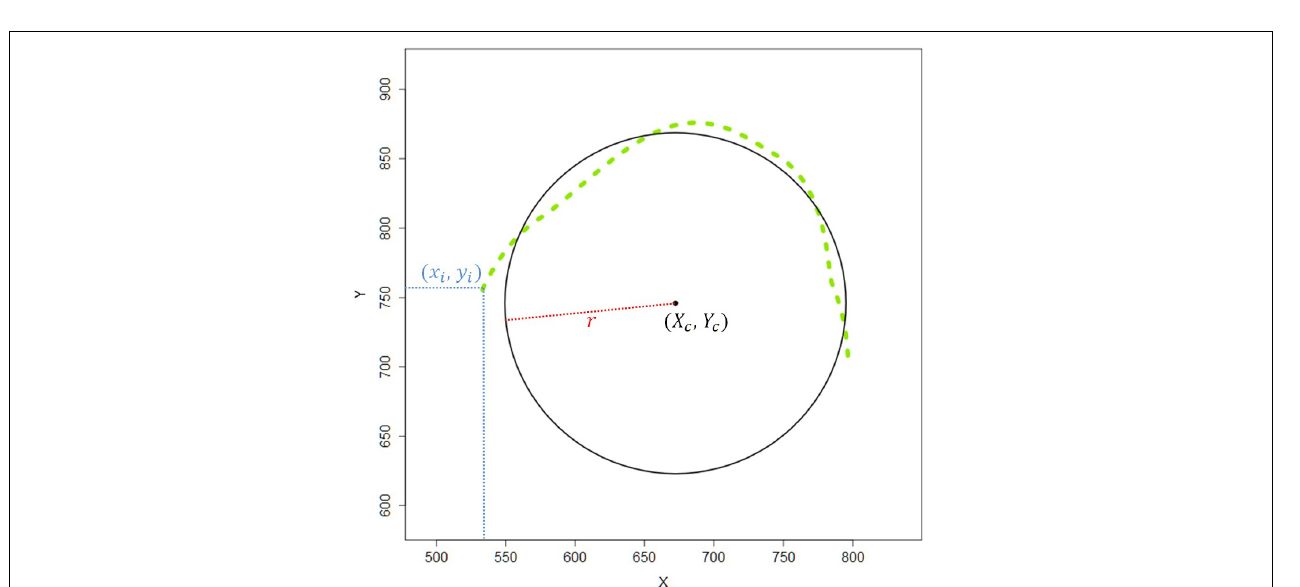
FIGURE A1 | Illustration for tongue center estimation as defined in Eq. 3. Dashed curvy green line is an example tongue contour. Dotted straight blue lines locate the first point of the tongue contour. Solid black circle is the best-fit circle calculated from the given tongue contour. Estimated center and radius of the best-fit circle are also displayed (color